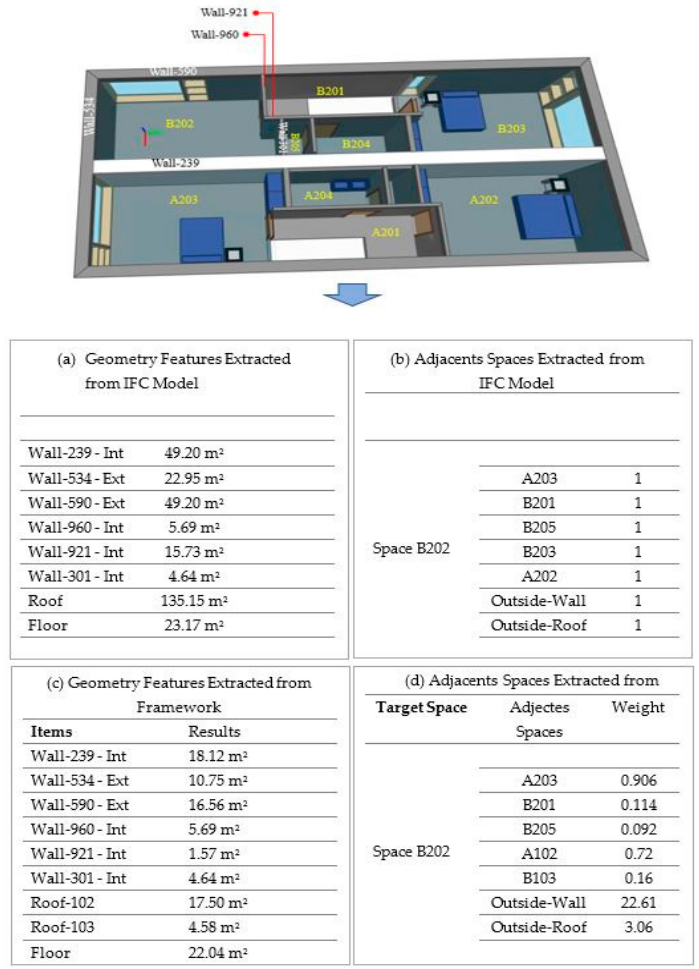
Figure 13. The extracted information from the IFC model and framework.